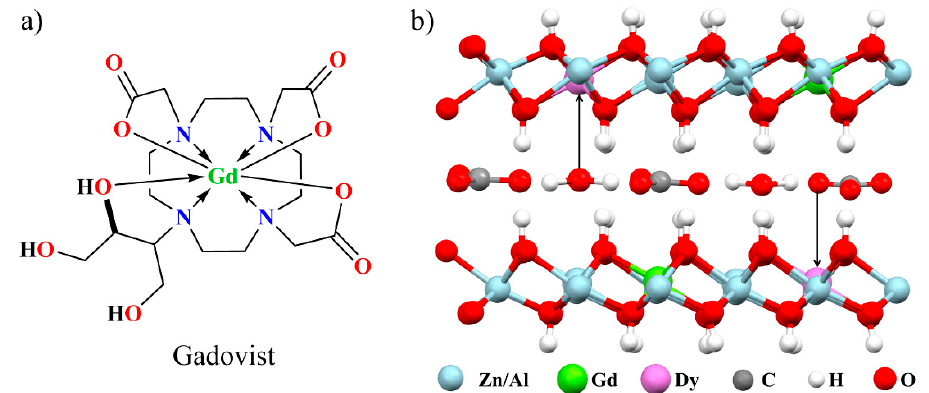
Figure 4. ( a ) T1- and ( b ) T2-relaxivity plots of aqueous suspensions of GdDy-LDHs with different Gd 3+ concentrations, and MRI images.